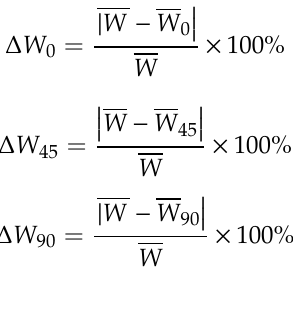
the waviness parameter—Wsk, ( d ) normal distributions for the waviness parameter-Wku.